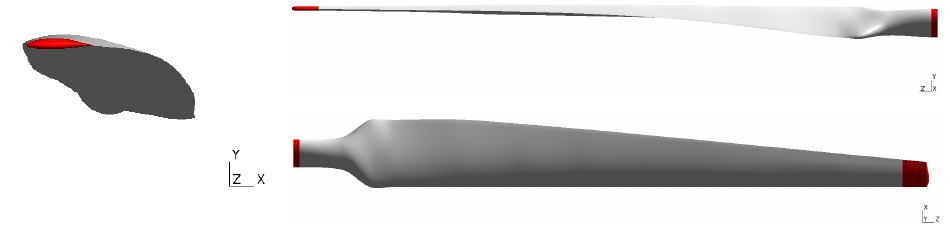
Figure 5. Different perspectives on the turbine-blade test geometry.